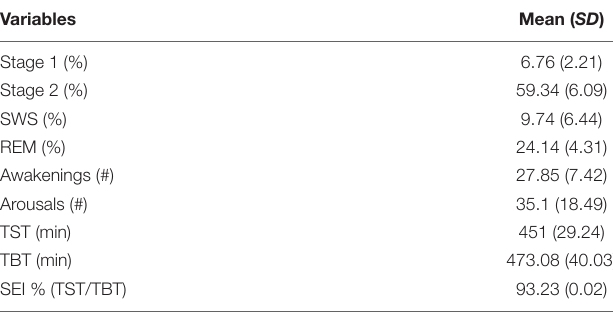
TABLE 2 | Polysomnographic